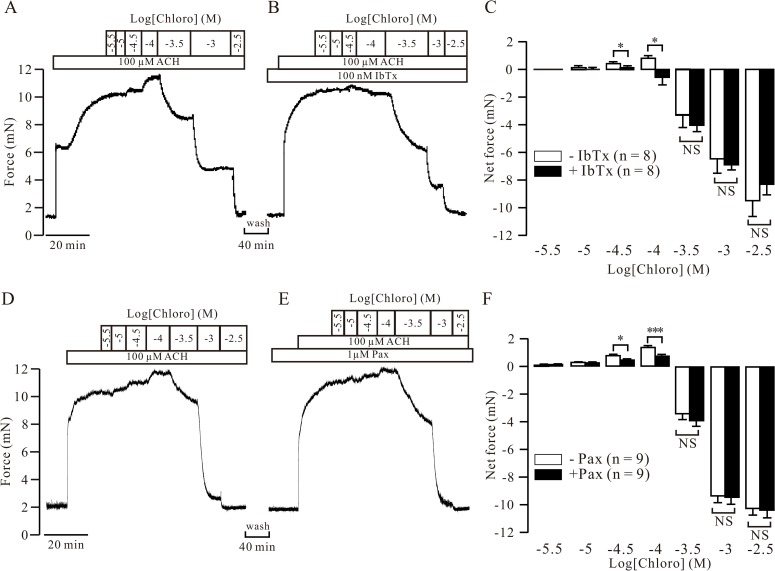
Role of BKs in chloro-induced force changes in precontracted mouse ASM.(A) ACH induced a steady state contraction in a mouse tracheal ring. Following cumulative additions of chloro, additional contractions were observed prior to the relaxations. (B) The same ring was washed and allowed to rest for 40 min. IbTx was then added and the same experiments were performed. The chloro-induced contractions were inhibited, the relaxations were not affected. (C) Averaged net changes in force from 8 experiments. In the absence of IbTx, lower concentrations (31.6 and 100 μM) of chloro induced contractions compared to that in the presence of IbTx. However, the relaxations in the two groups showed no differences. (D, E, F) The identical experiments were performed except that IbTx replaced by pax and similar results were obtained from 9 experiments. * denotes p < 0.05; *** denotes p < 0.001; NS denotes p > 0.05. To calculate the net contractile forces, the ACH-induced peak value was as the reference level, while the total value of ACH- and blocker-induced peak value will be the reference level for relaxant calculation. These data indicate that BKs involve in chloro-induced force alterations.